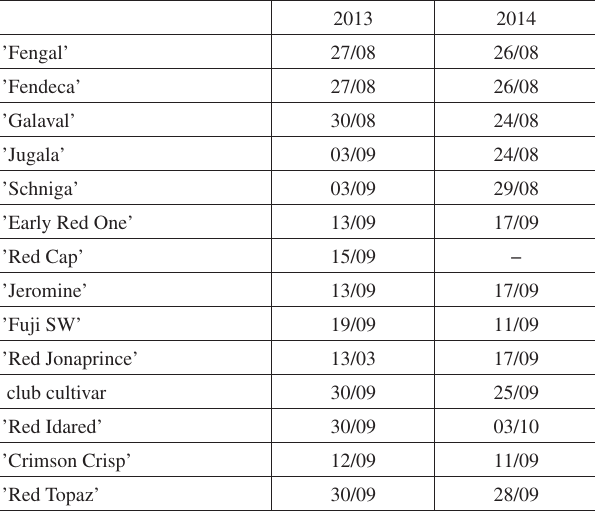
Table 2 : The harvest time (day/month) of the 14 apple cultivars (Nyírbátor, 2013 and 2014)